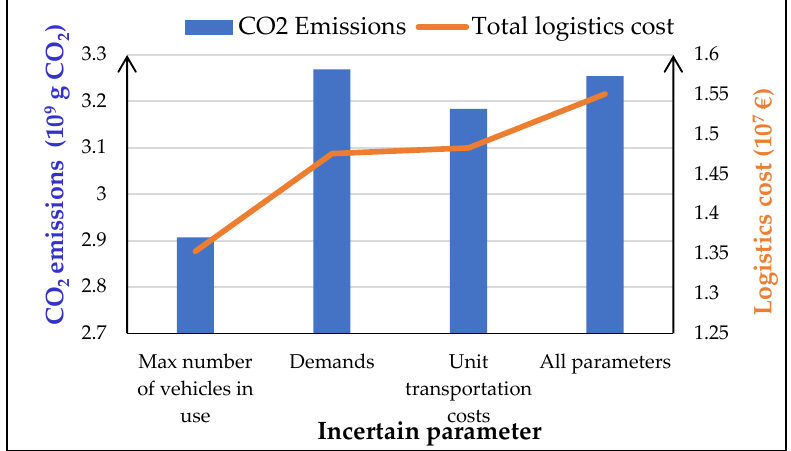
Figure 4. Impacts of different levels of uncertainty on costs and CO 2 emissions.